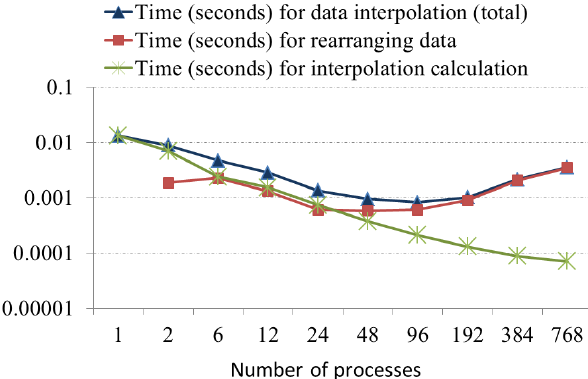
Fig. 12. The scaling performance of a 2-D interpolation in the FGOALS-gc: interpolating 19 2 Figure 12. The scaling performance of a 2-D interpolation in FGOALS-gc: interpolating 19 horizontal fields from the GAMIL2 horizontal fields from the GAMIL2 grid to the LICOM2 grid on the coupler component. 3 grid to the LICOM2 grid on the coupler